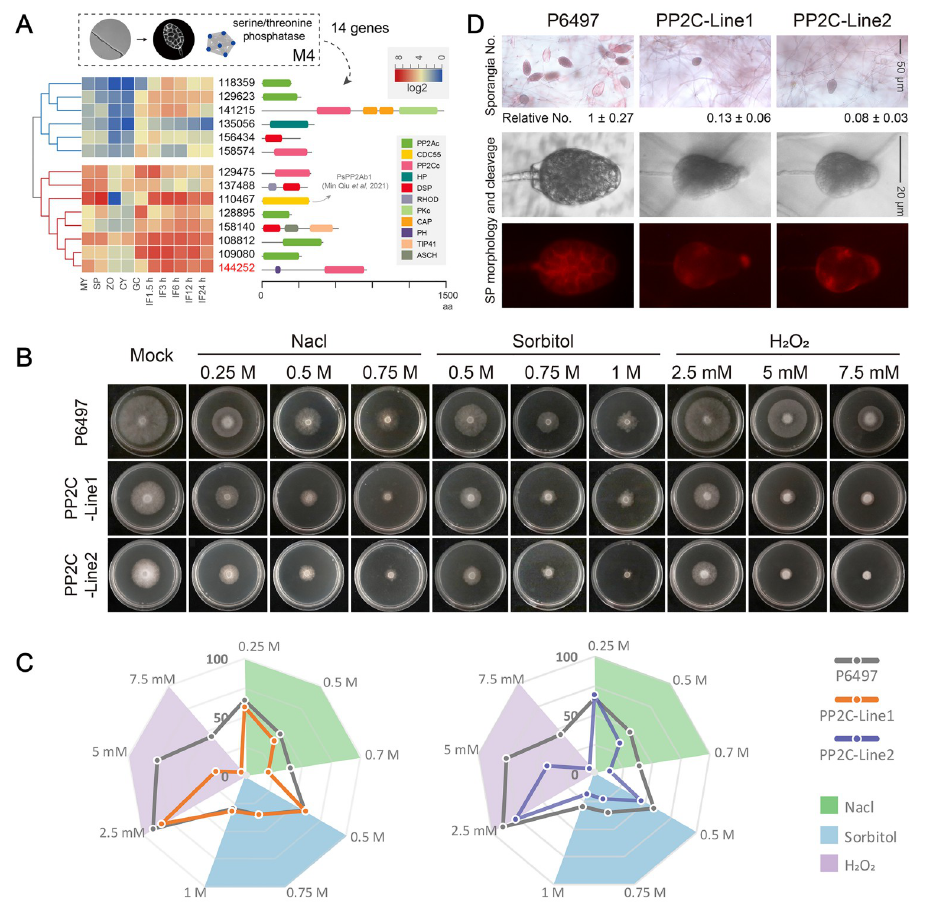
Fig 3. Serine/threonine phosphatase (PP2C) required for sporangia formation and mycelial growth in P . sojae . (A) Hierarchical clustering of transcription levels of the genes from serine/threonine phosphatase cluster. Domain structure of each gene were displayed on the right panel. (B) Growth characteristics of the wild-type (P6497) and PP2C-knockout mutants (PP2C-Line1 and PP2C-Line2) on V8 agar medium without (Mock) or with different concentrations of NaCl, Sorbitol or H 2 O 2 . (C) Rader maps display the relative colony diameters after 4 days of growth in different stresses. Colony diameters were measured in each independent biological experiment after 4 days of growth. And Relative colony diameters were calculated for each treatment relative to growth on V8 agar medium only. Different stress treatments were colored with pale green (Nacl), thistle (H 2 O 2 ), and sky blue (Sorbitol). (D) Upper panel: The numbers of sporangia in wild-type (P6497) and PP2C-knockout mutants (PP2C-Line1 and PP2C-Line2). The relative numbers of sporangia were labeled under the pictures. Lower panel: The sporangia morphology and cytoplasm cleavage within sporangia were observed in the wild-type (P6497) and PP2C-knockout mutants (PP2C-Line1 and PP2C-Line2).